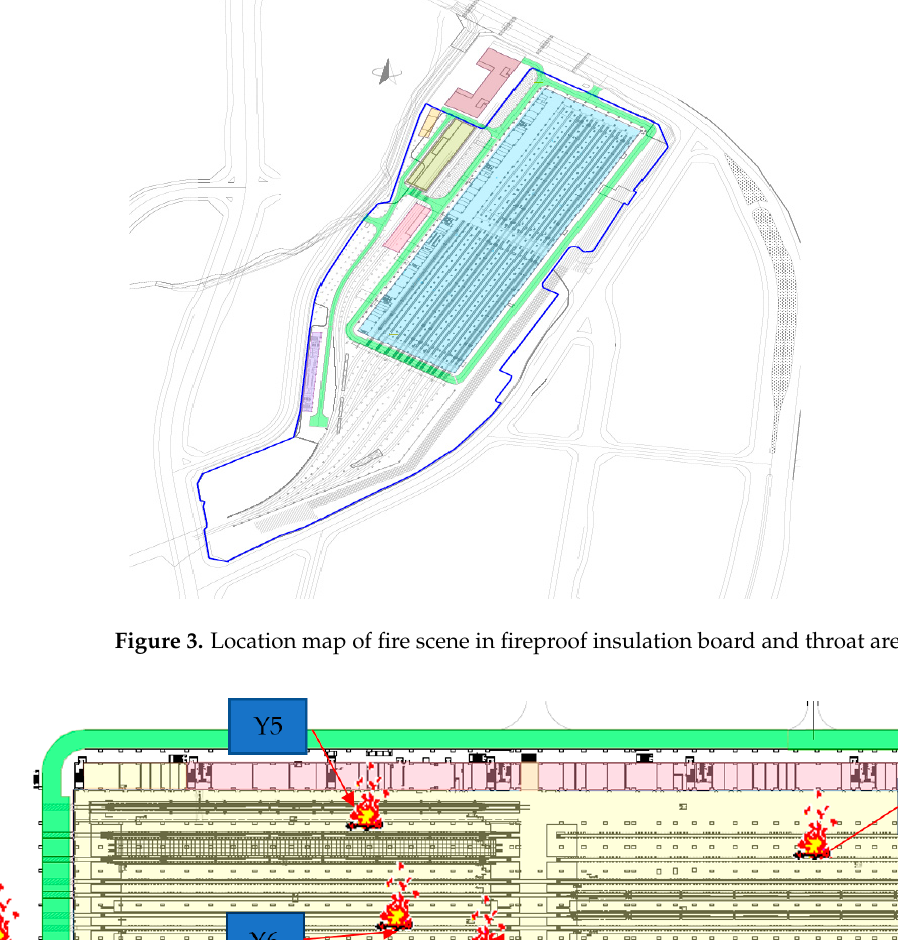
Figure 4. Application library fire scene location map. Smoke scenes in different location were noted from Y1 to Y6..